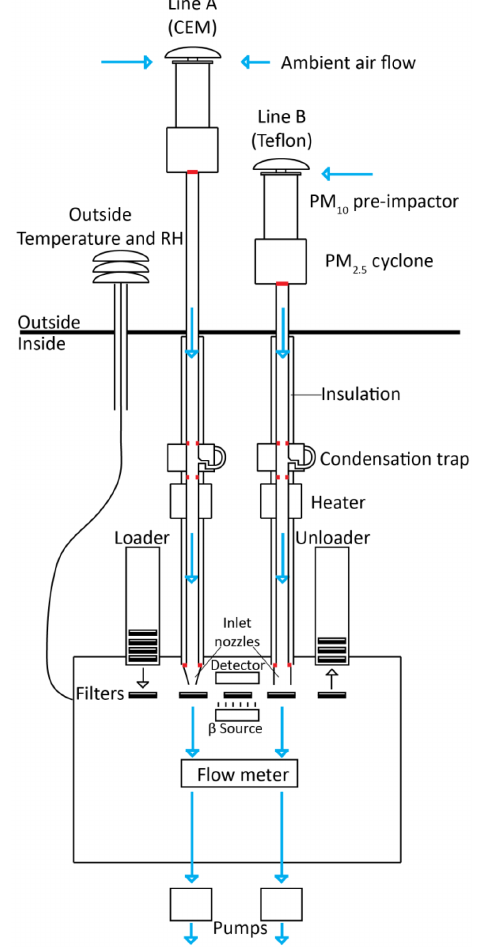
Figure 4. Diagram of Teledyne Advanced Pollution Instrumenta- tion (TAPI) 602 Beta Plus particulate monitor (modified from Pierce and Gustin, 2017). Blue indicates the airflow through the instru- ment. Red indicates where aluminum tubing is in contact with an- other surface: the base of the PM 2 . 5 cyclones, before and after the condensation water traps, and where the sample tubes entered the TAPI measurement box above the inlet